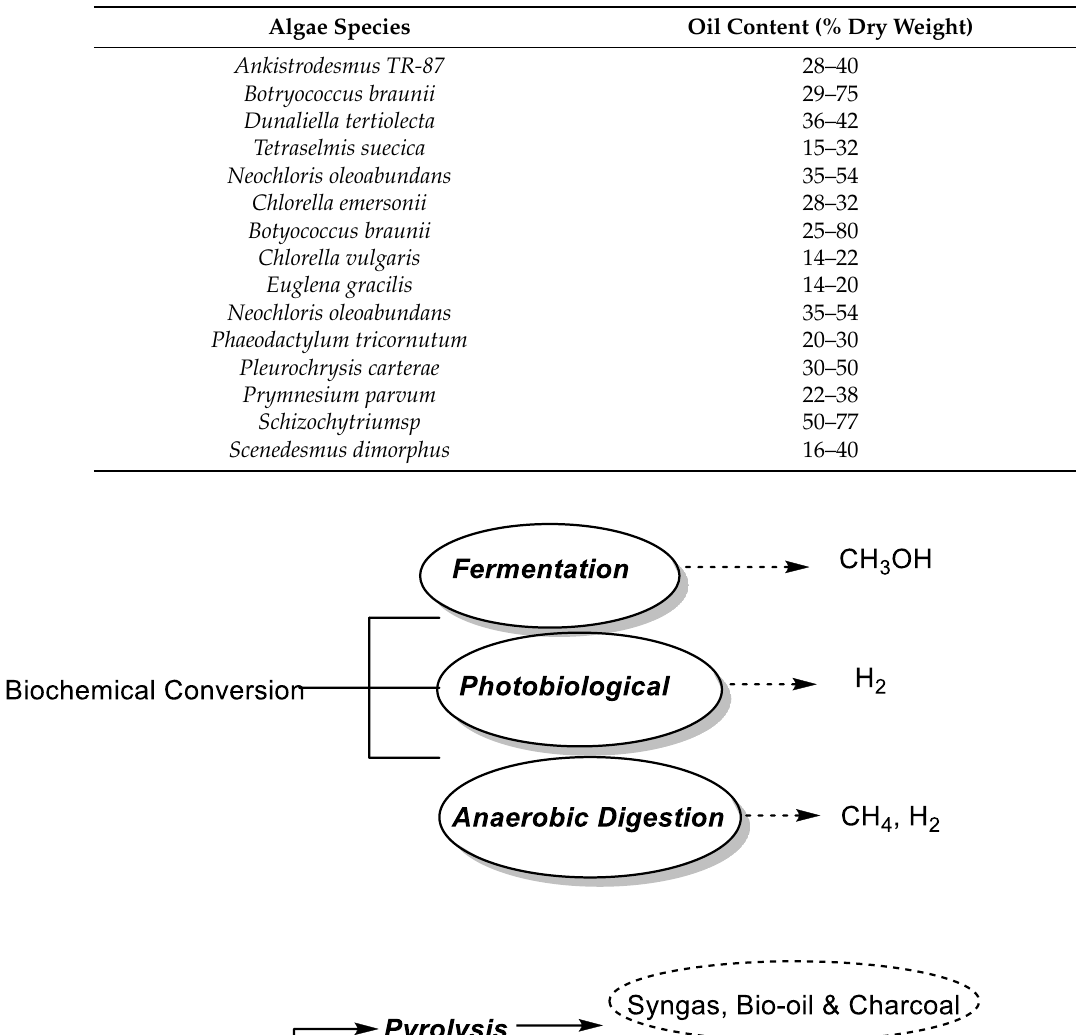
Table 1. Lipid content of some selected species of microalgae.